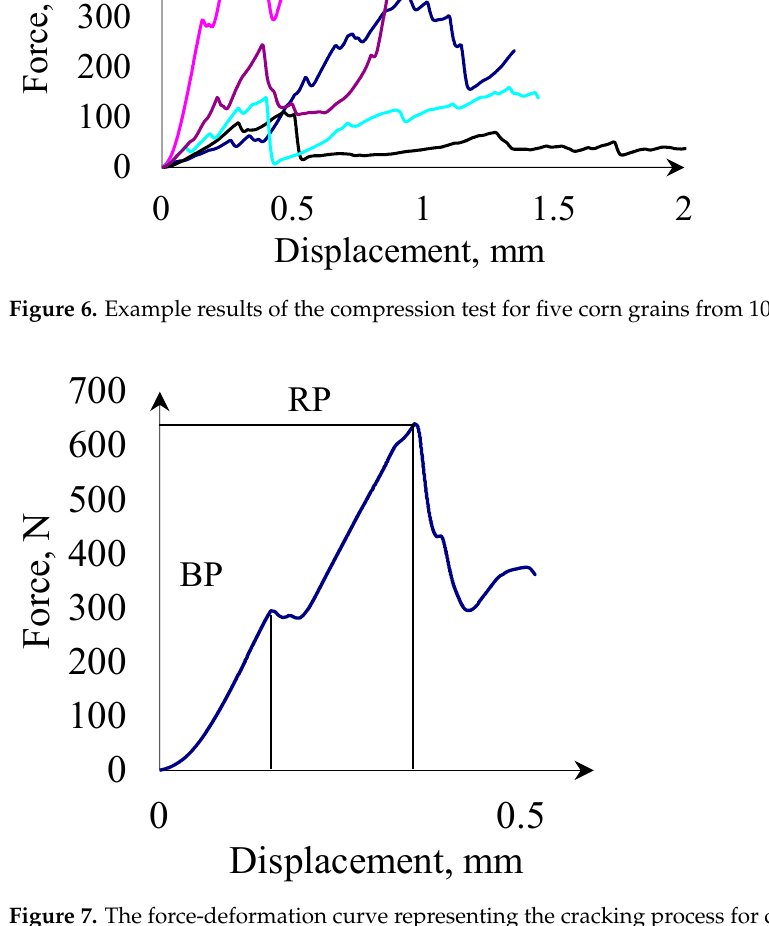
Figure 7. The force-deformation curve representing the cracking process for corn grains.